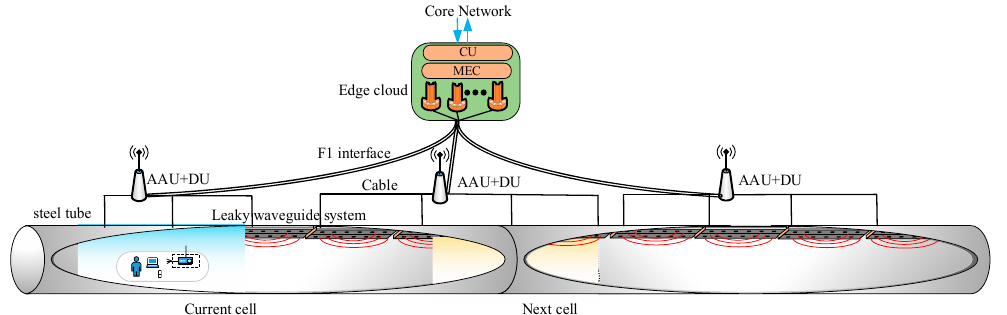
Figure 5. The diagram of the C-RAN architecture for Hyperloop.